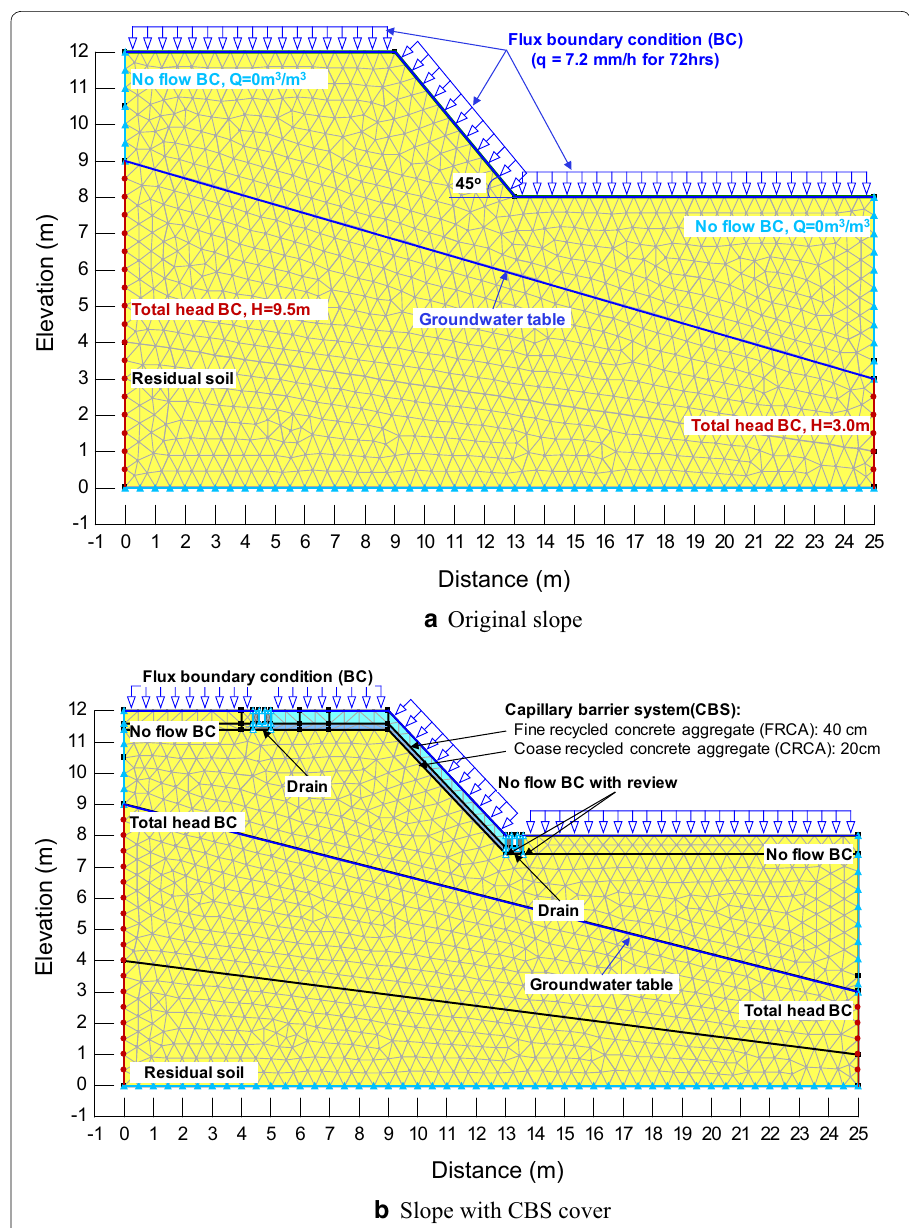
Fig. 14 Slope geometry and boundary